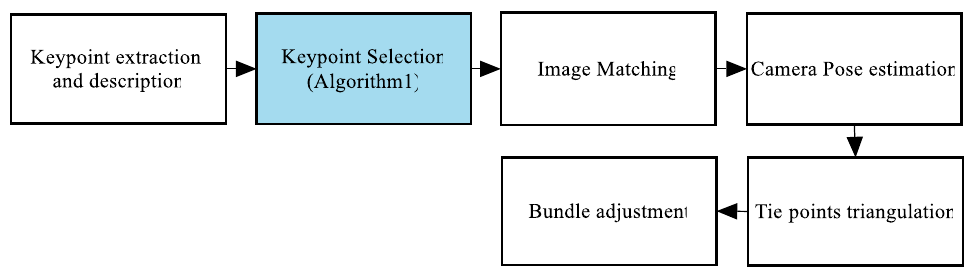
Figure 3. The keypoint selection module in the Structure from Motion (SfM) pipeline.